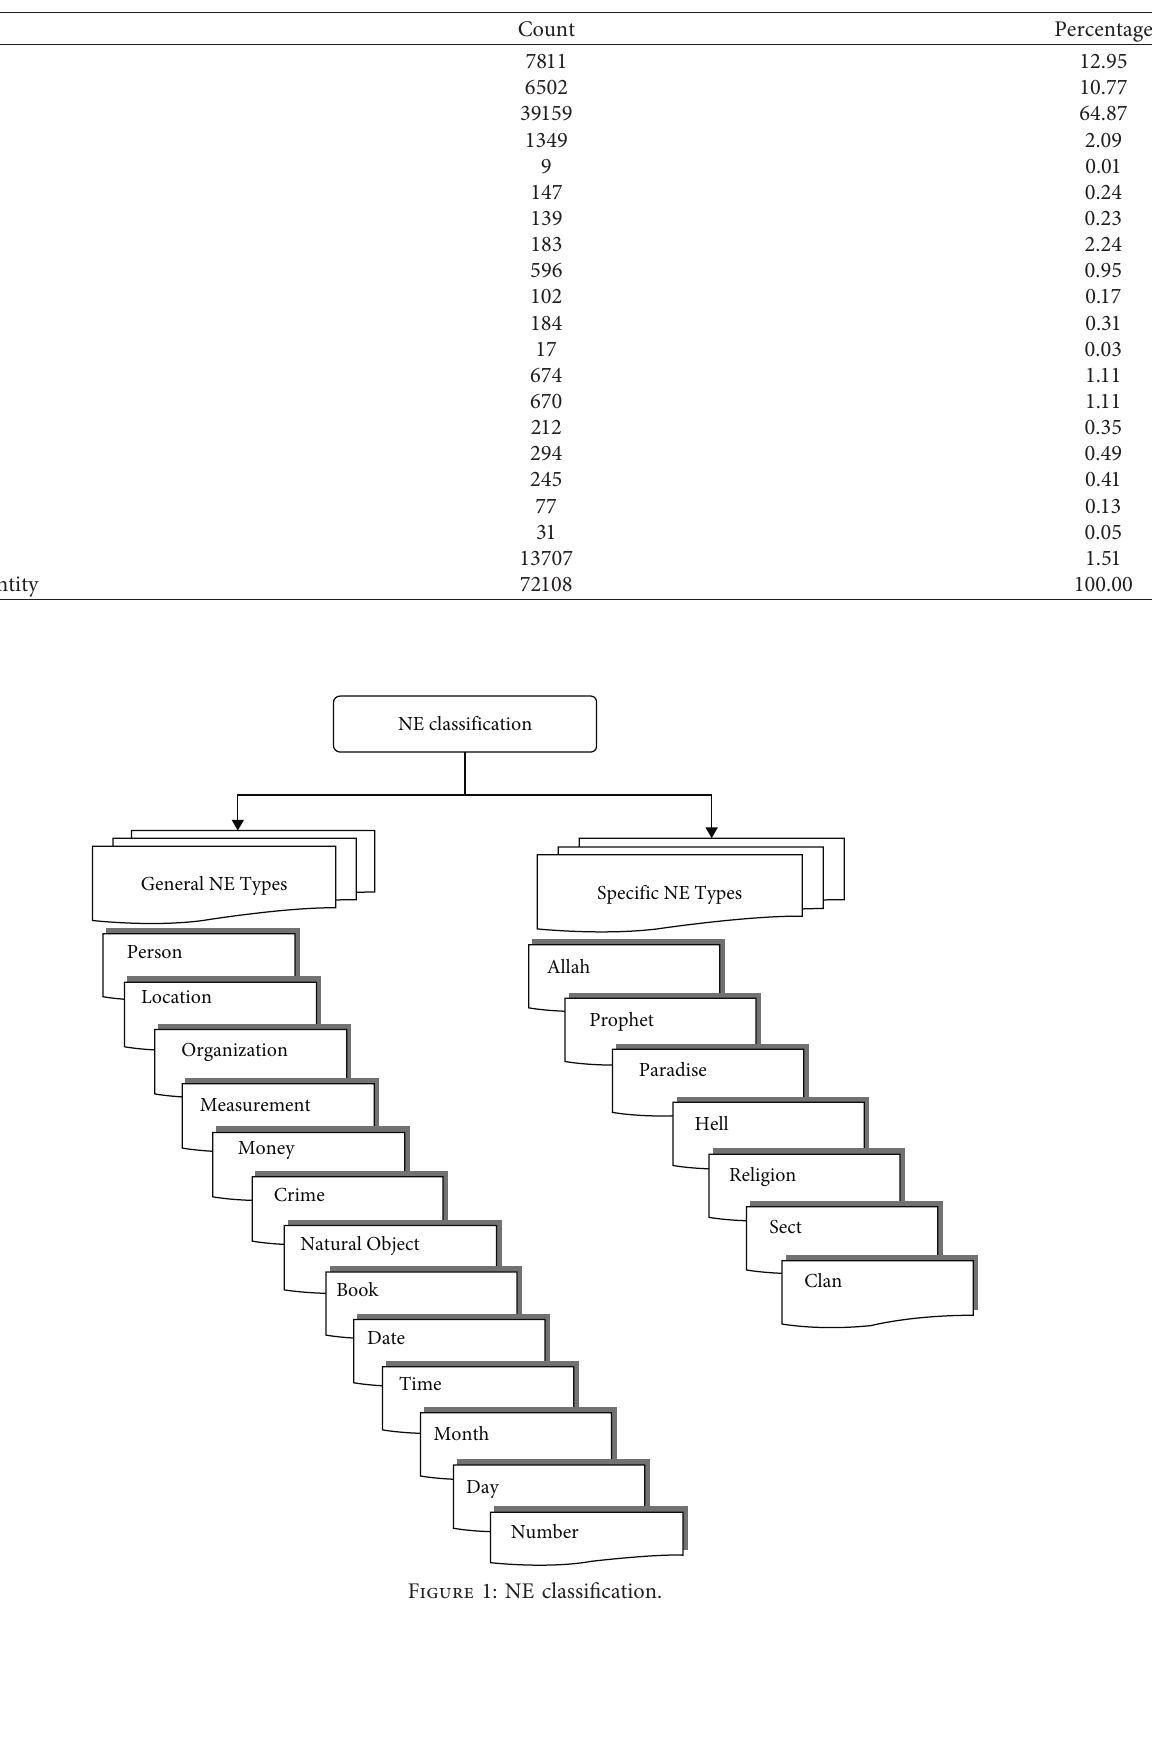
Table 1: Word count and percentage of each NE class.